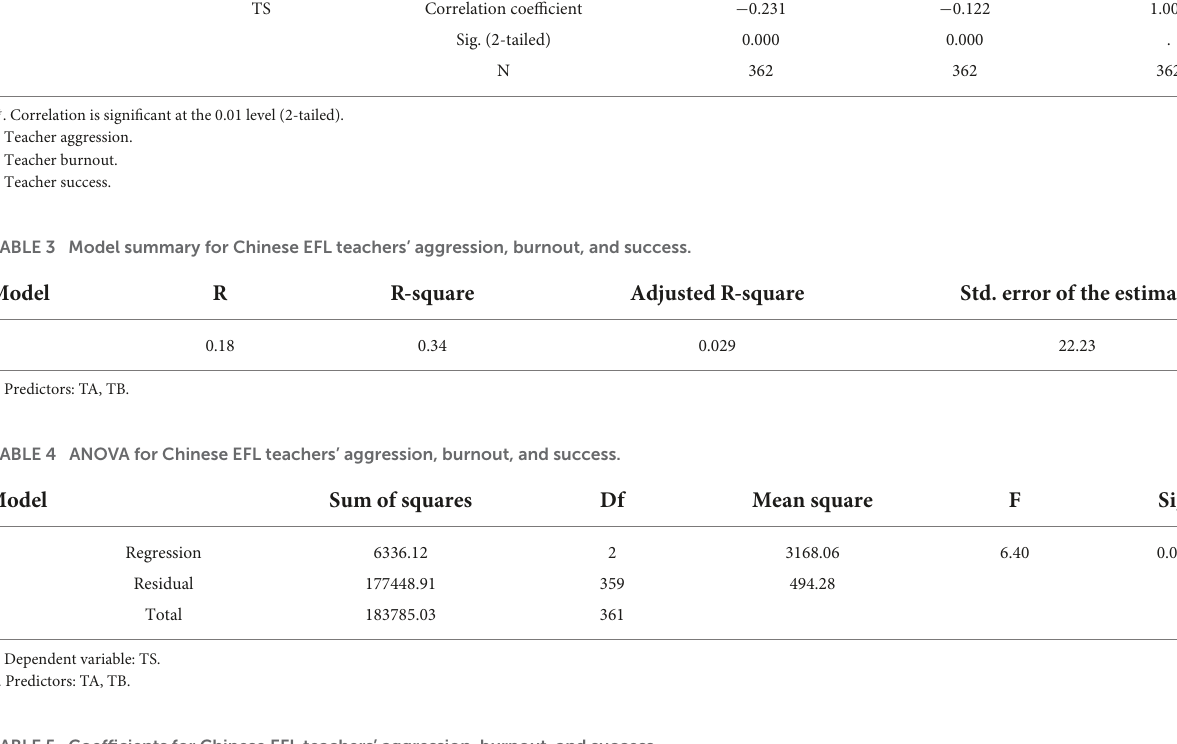
TABLE 5 Coefficients for Chinese EFL teachers’ aggression, burnout, and success.